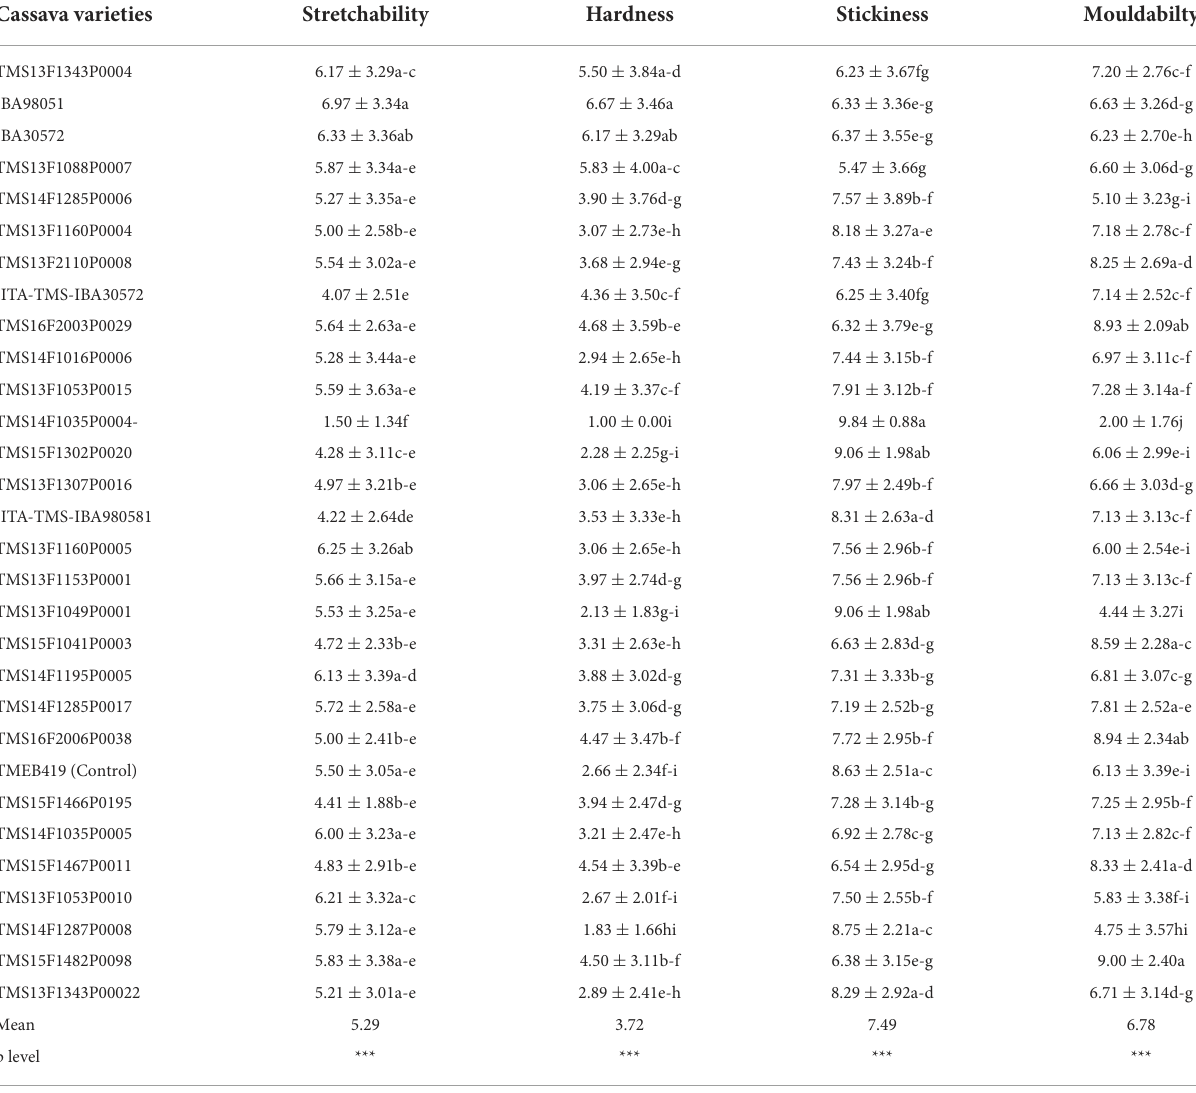
TABLE 6 Sensory texture attributes of eba produced from the cassava genotypes and the control variety. Cassava